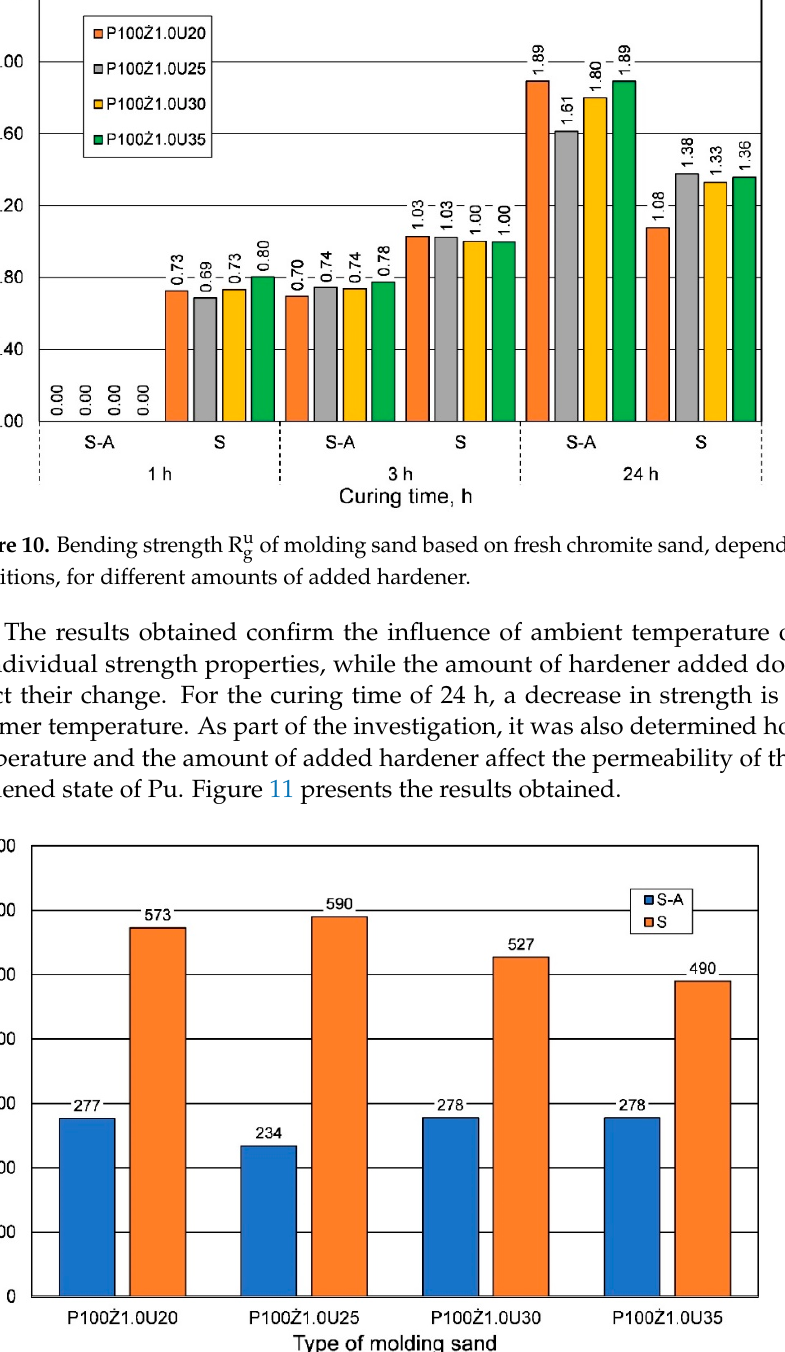
Figure 9. Tensile strength R (cid:2923)(cid:2931) of molding sand based on fresh chromite sand, depending on weather conditions, for different amounts of hardener added.